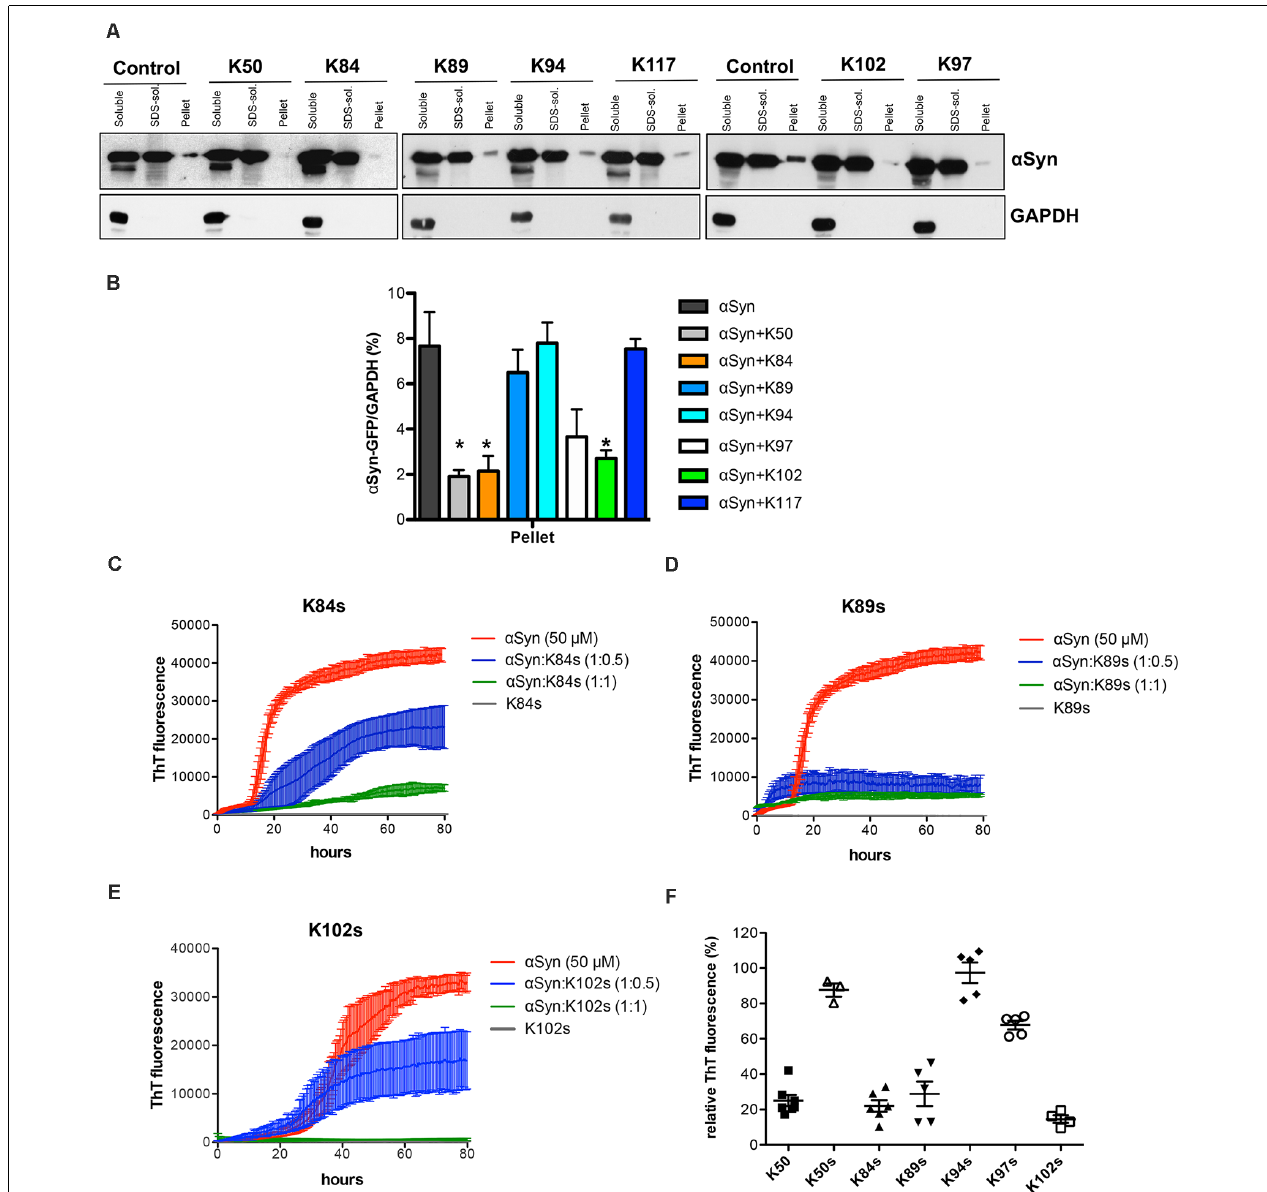
FIGURE 5 | Distribution of α Syn-GFP levels across different solubility fractions. (A) Yeast cells, expressing GAL1 -driven α Syn-GFP from three genomic copies and the indicated peptide constructs or the corresponding empty vector (control) were induced for 6 h in galactose medium. Starting from an equal number of cells, crude protein extracts were prepared and fractionated by ultracentrifugation to produce soluble, SDS-soluble and SDS-insoluble fractions (pellet), revealing the level of insoluble α Syn. Equal amounts from all fractions were analyzed by immunoblotting with anti- α Syn. The membranes were stripped and probed with an anti-GAPDH antibody as a loading control. (B) Densitometric analysis of the immunodetection of α Syn-GFP relative to GAPDH loading control. The significance of differences was calculated with t -test vs. α Syn (* p < 0.05; n = 4). (C) Peptide-mediated effect on the amyloidogenic properties of α Syn in vitro . Aggregation kinetics of α Syn in the presence and absence of the synthetic peptides K84s (C) , K89s (D) , or K102s (E) monitored by ThT fluorescence emission. α Syn was incubated at a concentration of 50 µ M in the absence or upon addition of the peptides in the indicated molar ratios at time point 0. The ThT fluorescence emission was recorded every 15 min for 100 h. Incubation of the peptides alone served as a control. Representative curves showing the fluorescent signal over time. (F) Quantification of the relative ThT fluorescence signal in presence of the indicated peptides at molar ratio 1:1 (1:0.2 for K50) after 100 h relative to α Syn alone. The data are mean of five independent